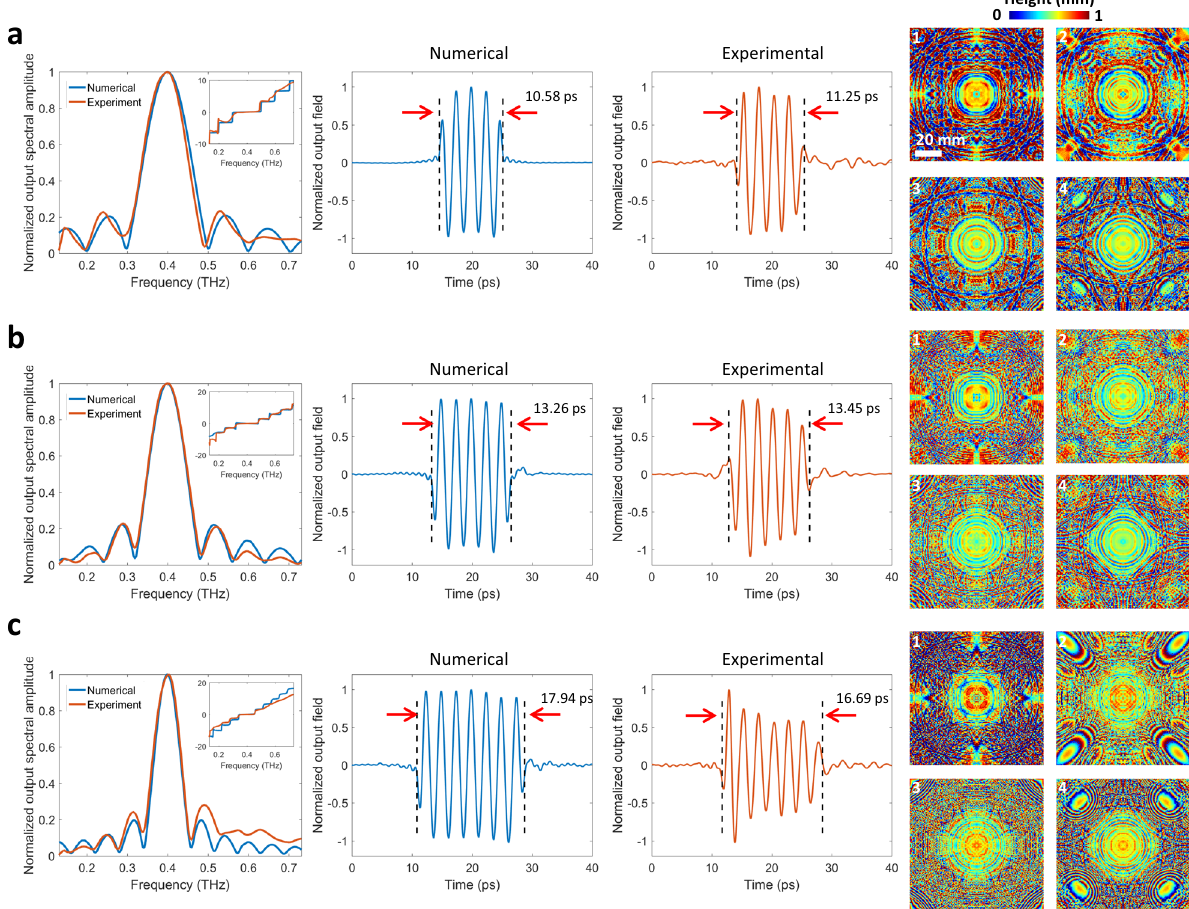
Fig. 3 Experimental validation of different generic pulse shaping diffractive networks. From left to right, the numerically computed (blue) and the experimentally measured (orange) normalized spectral amplitudes are illustrated with the inset plots showing the corresponding unwrapped spectral phase pro fi les; the numerically calculated (blue) normalized output pulse and the experimentally measured (orange) normalized output pulse are also shown along with the thickness pro fi les of the diffractive layers resulting from deep learning-based training for synthesizing the desired (ground truth) square pulses with pulse-widths of ( a ) 10.52 ps, ( b ) 13.02 ps, and ( c ) 17.98